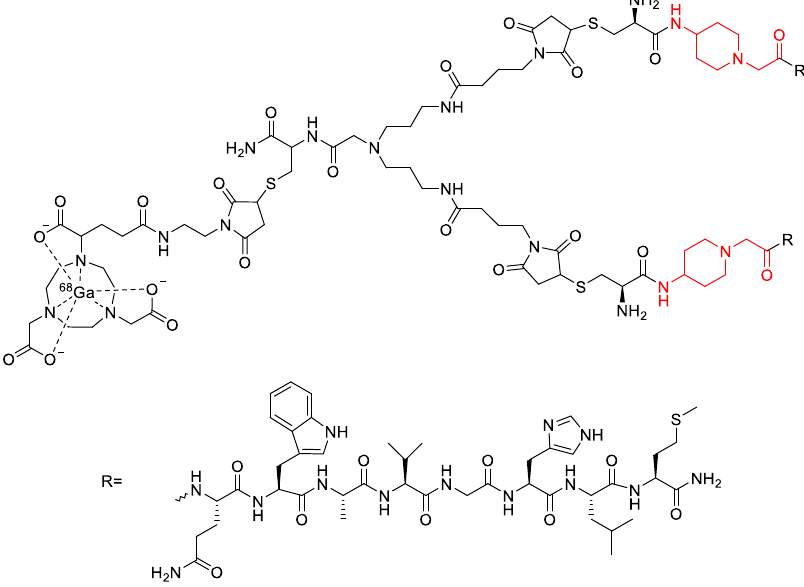
Figure 20. Bombesin-based radiopharmaceuticals investigated by Bacher et al., with the linker location and linkers highlighted in red [113].